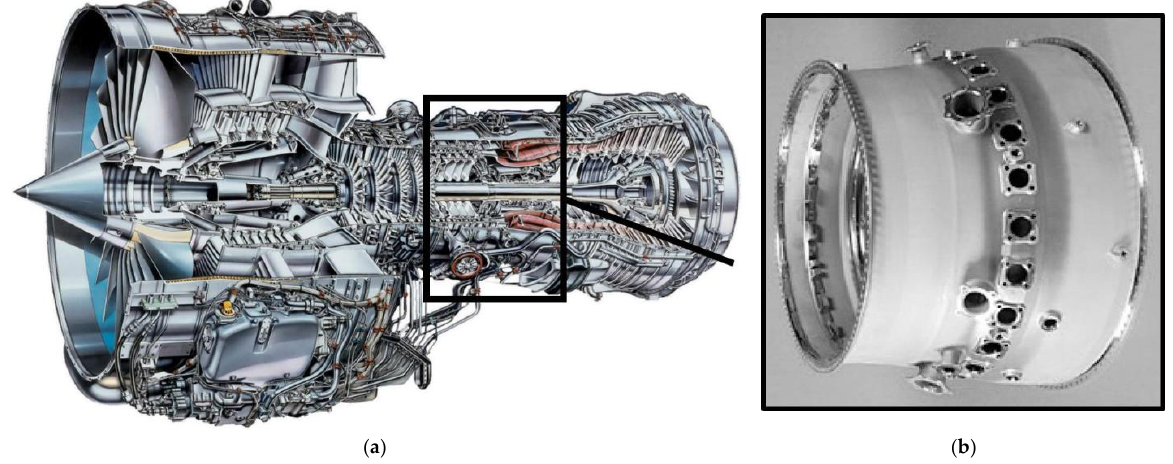
Figure 1. ( a ) V2500 engine model; ( b ) turbofan engine diffuser model.